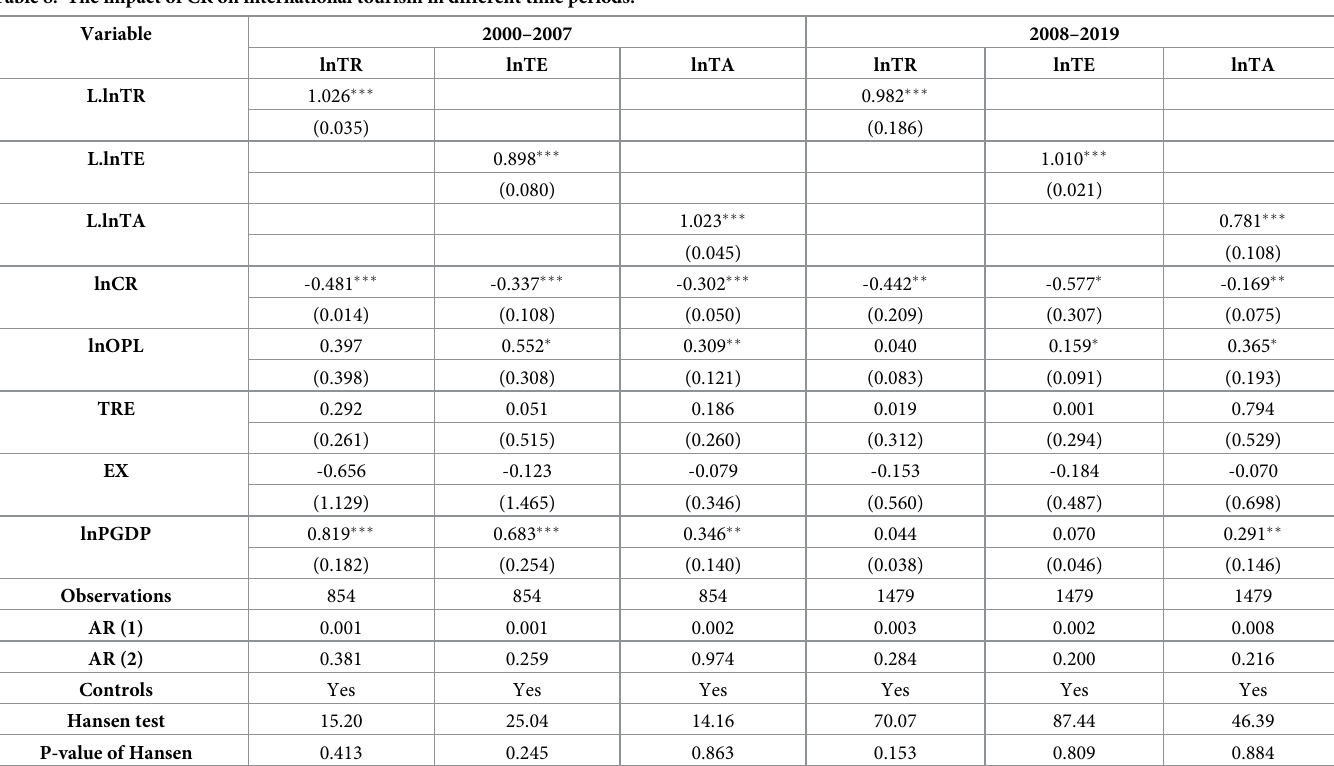
Table 8. The impact of CR on international tourism in different time